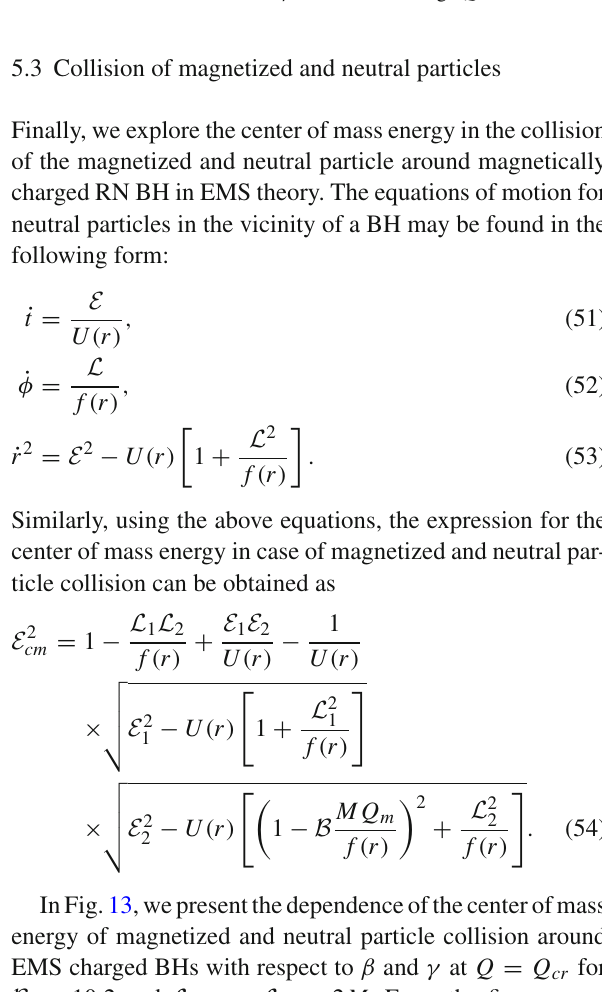
Fig. 11 Dependence of center of mass energy of two magnetized particles collision for different values of β and critical charge Q